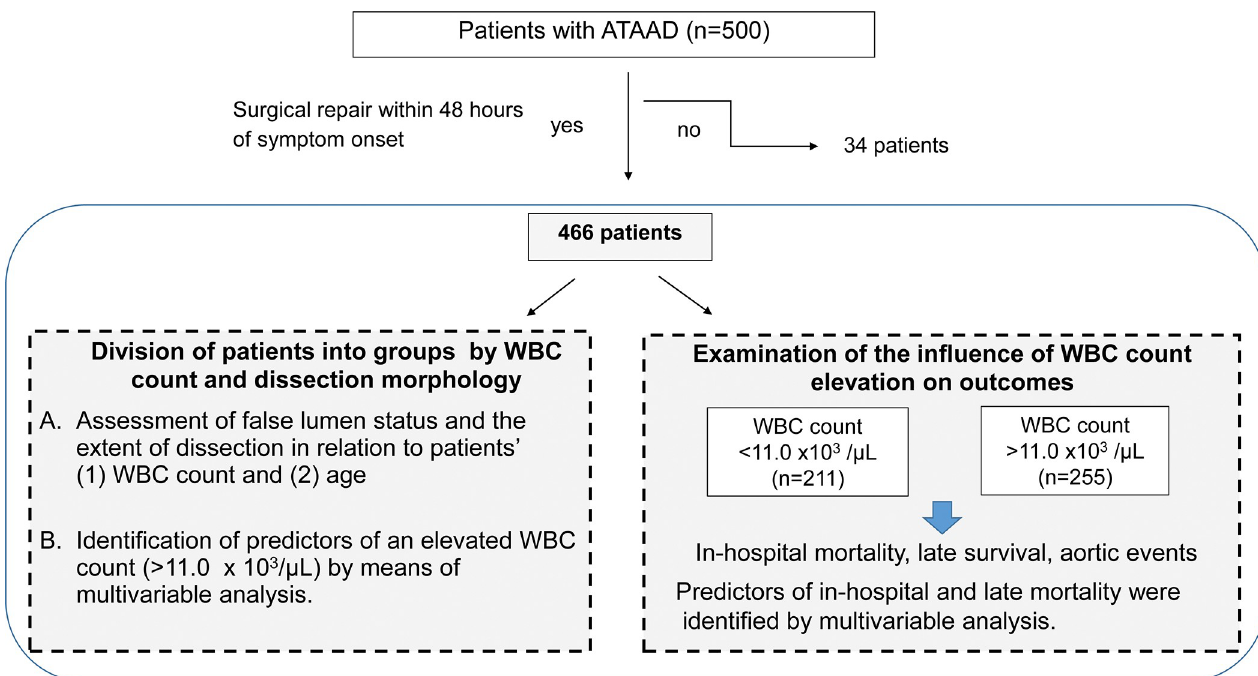
Fig 1. Flow diagram of the study, including patient selection and factors addressed. ATAAD, acute type A aortic dissection; WBC, white blood cell.